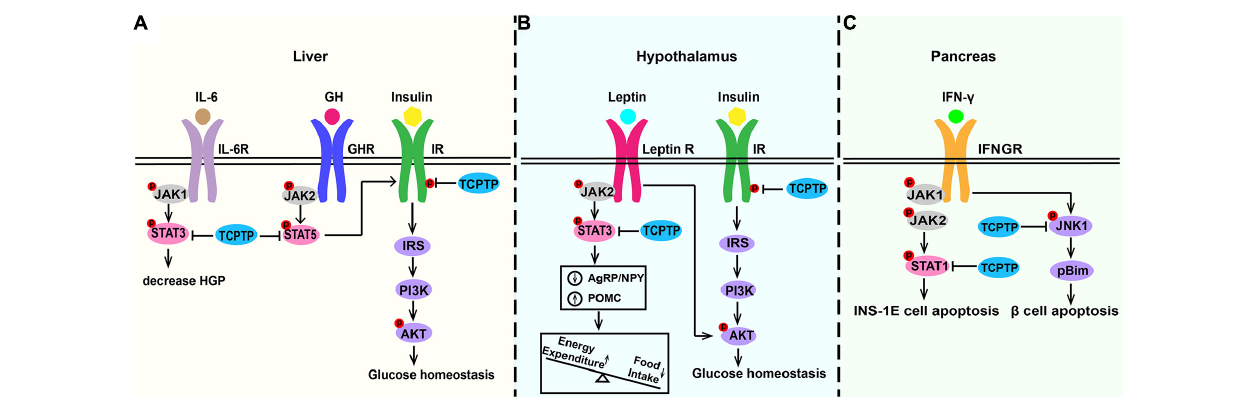
FIGURE 4 | Molecular pathways of TCPTP in regulating glucose metabolism in (A) liver, (B) hypothalamus, and (C) pancreas. In liver, TCPTP can dephosphorylate IR and STAT3 to inhibit insulin signaling and IL-6 signaling separately to promote hepatic glucose output. In hypothalamus, TCPTP may act as the principal phosphatase to attenuate insulin and leptin signaling by inhibiting insulin-induced AKT phosphorylation and leptin-induced STAT3 signaling. In pancreas, TCPTP modulates IFN-induced β cell death by dephosphorylating pro-apoptotic protein Bim via JNK1. Furthermore, TCPTP is capable of effectively suppressing the IFN- γ /STAT1 signaling pathway in INS-1E cells. TCPTP, T cell protein tyrosine phosphatase; IL-6, interleukin-6; IL-6R, interleukin-6 receptor; HGP, hepatic glucose production; GH, growth hormone; GHR, growth hormone receptor; IR, insulin receptor; Leptin R, leptin receptor; IFN- γ , interferon- γ ; IFNGR, interferon- γ receptor; JAK, Janus activated kinase; STAT, signal transducer and activator of transcription; IRS, insulin receptor substrate; PI3K, phosphatidylinositol 3-kinase; AKT, protein kinase B; JNK1, c-Jun N-terminal kinase